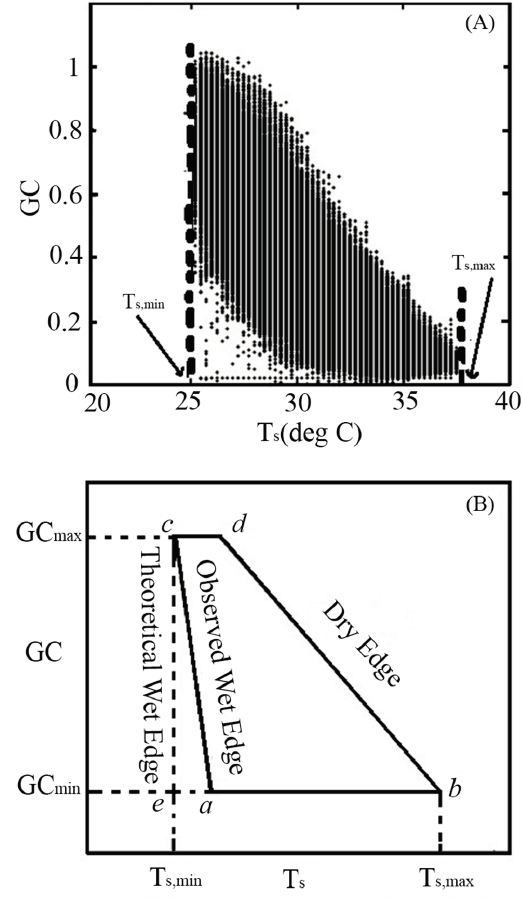
Figure 1. Ground cover (GC) plotted vs. surface temperature (T s ). ( A ) Actual distribution of GC vs. T s for pixels in a Landsat-7 image of an agricultural region; ( B ) Diagrammatic representation of features of the distribution of T s -GC space. Points a – d indicate the vertices of the trapezoidal representation of the distribution of points